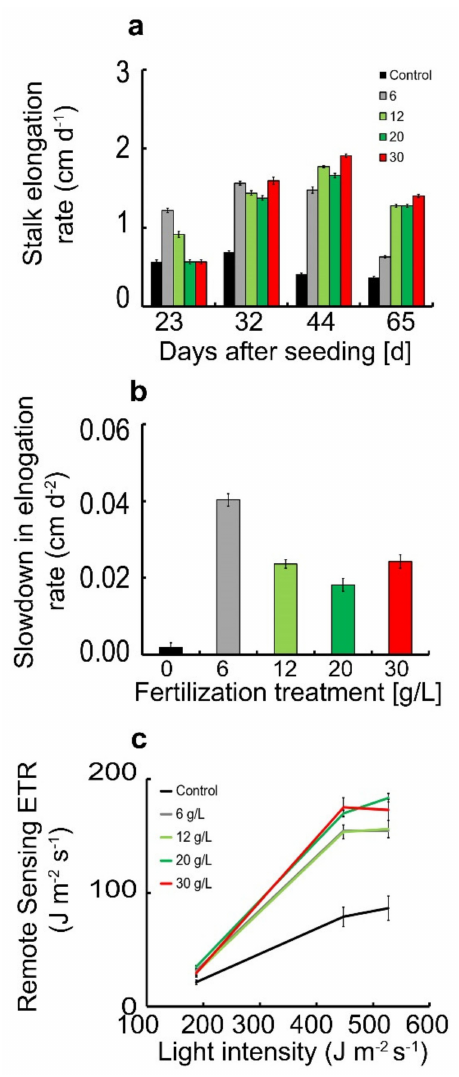
Figure 6. ETR index responds to plant health in Z. mays . ( a ) Stalk elongation as a proxy for biomass production of Z. mays along a fertilization gradient. Color scheme indicates black, grey, light green, green and red colors which correspond to control (irrigation only), 6, 12, 20 and 30 g of total nitrogen per L of irrigation. n = 5, with 4 technical repeats per each biological repeat and error bars representing standard error of the mean. ( b ) The change in elongation rate between the 44th and the 65th day. ( c ) Light response curve of the ETR index at three time instances during the 65th day after sowing. The points are connected in straight lines in order to present the trend of the curve. n = 5, with 4 technical repeats per each biological repeat, and error bars represent standard error of the